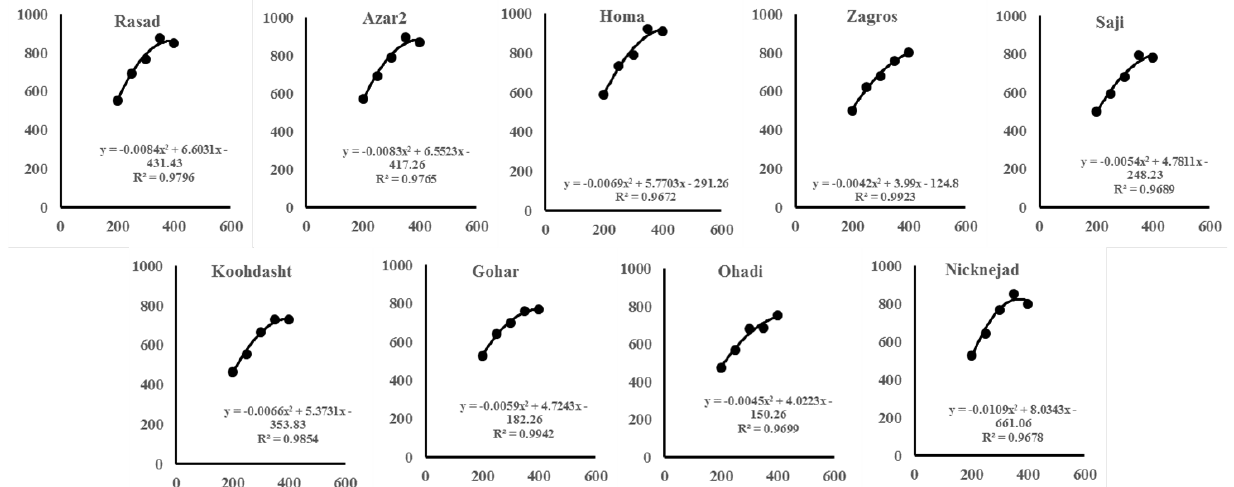
Fig. 3. Relations between the biological yield per unit area and plant density in wheat cultivars. X axis: Plant population (plant m -2 ); Y axis: Biological yield (g m -2 )